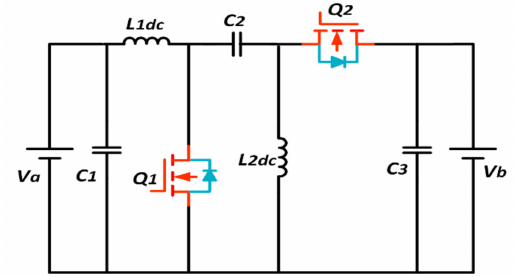
Figure 5. Bidirectional SEPIC–ZETA DC/DC converter [38].